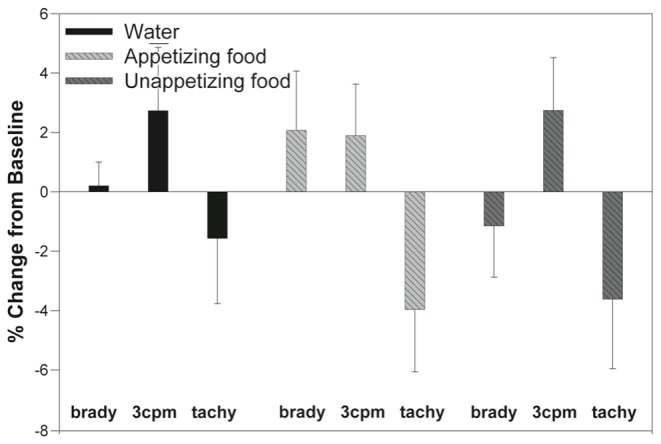
Change in EGG dominant power in all 3 frequency bands (percent bradygastria, normogastria, tachygastria) from baseline during relaxation.As can be seen, the response to a water load (left) is lower than with imagining of an appetizing meal (middle) and the unappetizing meal (right). Note that error bars are understood to extend in both directions symmetrically.